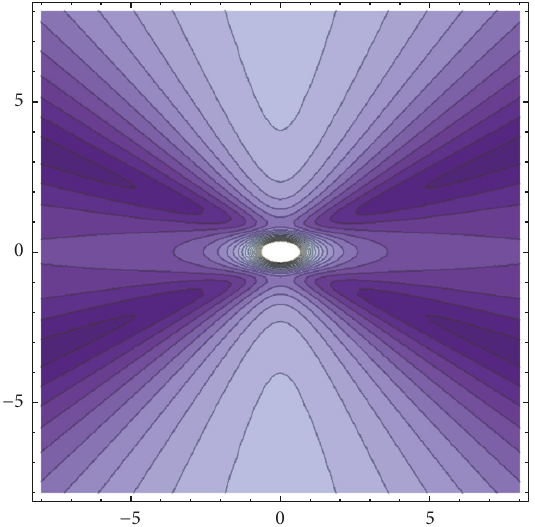
Figure 19: Contour of the rouge wave structure determined by the module of solution (83).